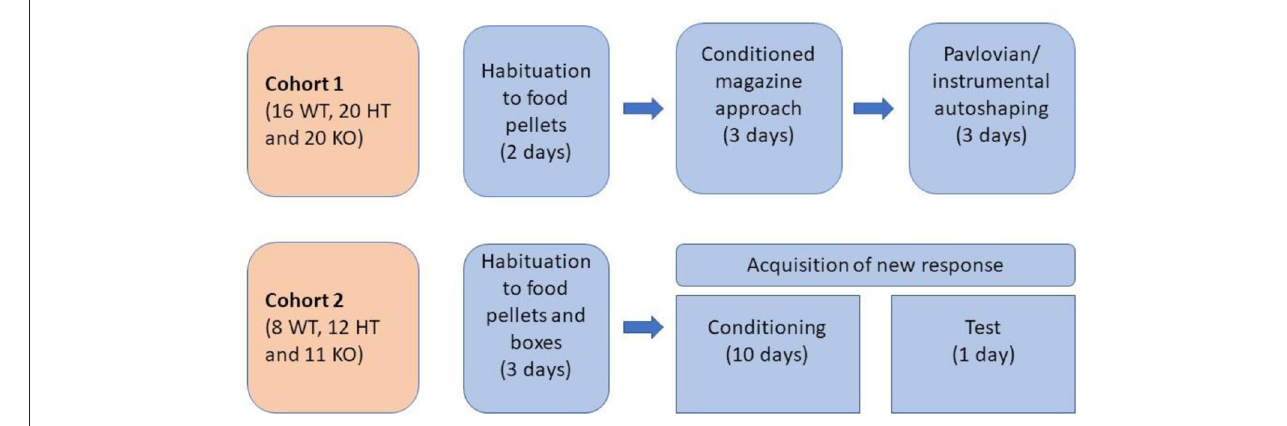
FIGURE 1 | Design of behavioral testing.